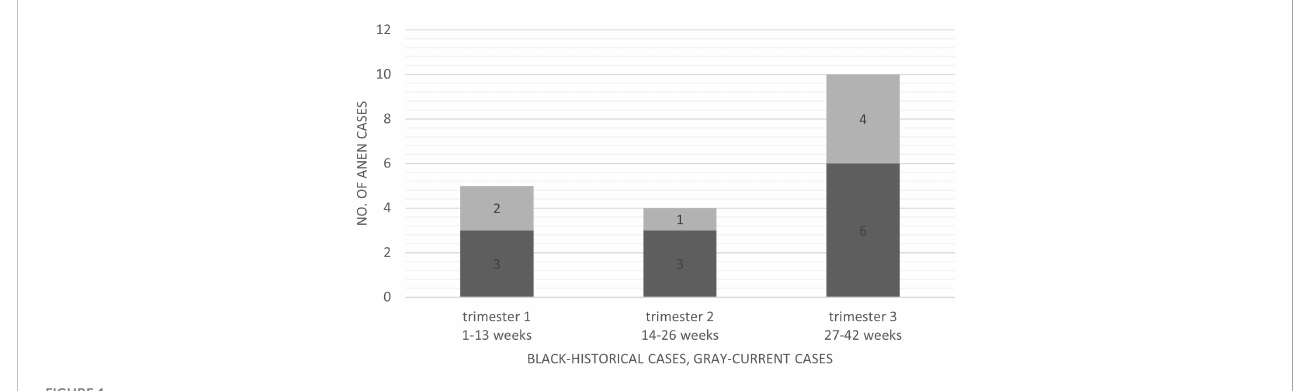
FIGURE 1 Appendiceal neuroendocrine neoplasms diagnosed during pregnancy divided by pregnancy trimester at